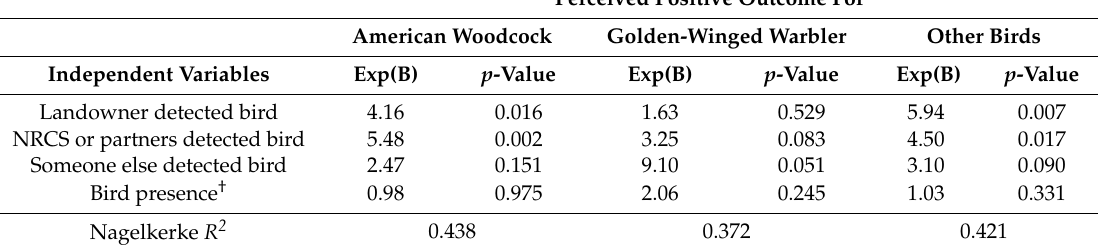
Table 2. Summary of logistic regression models for predicting landowner perceived positive e ff ect on American Woodcock, Golden-winged Warbler, and other birds from Natural Resources Conservation Service (NRCS) early successional forest habitat program participation, eastern United States, February–May 2017 (n =